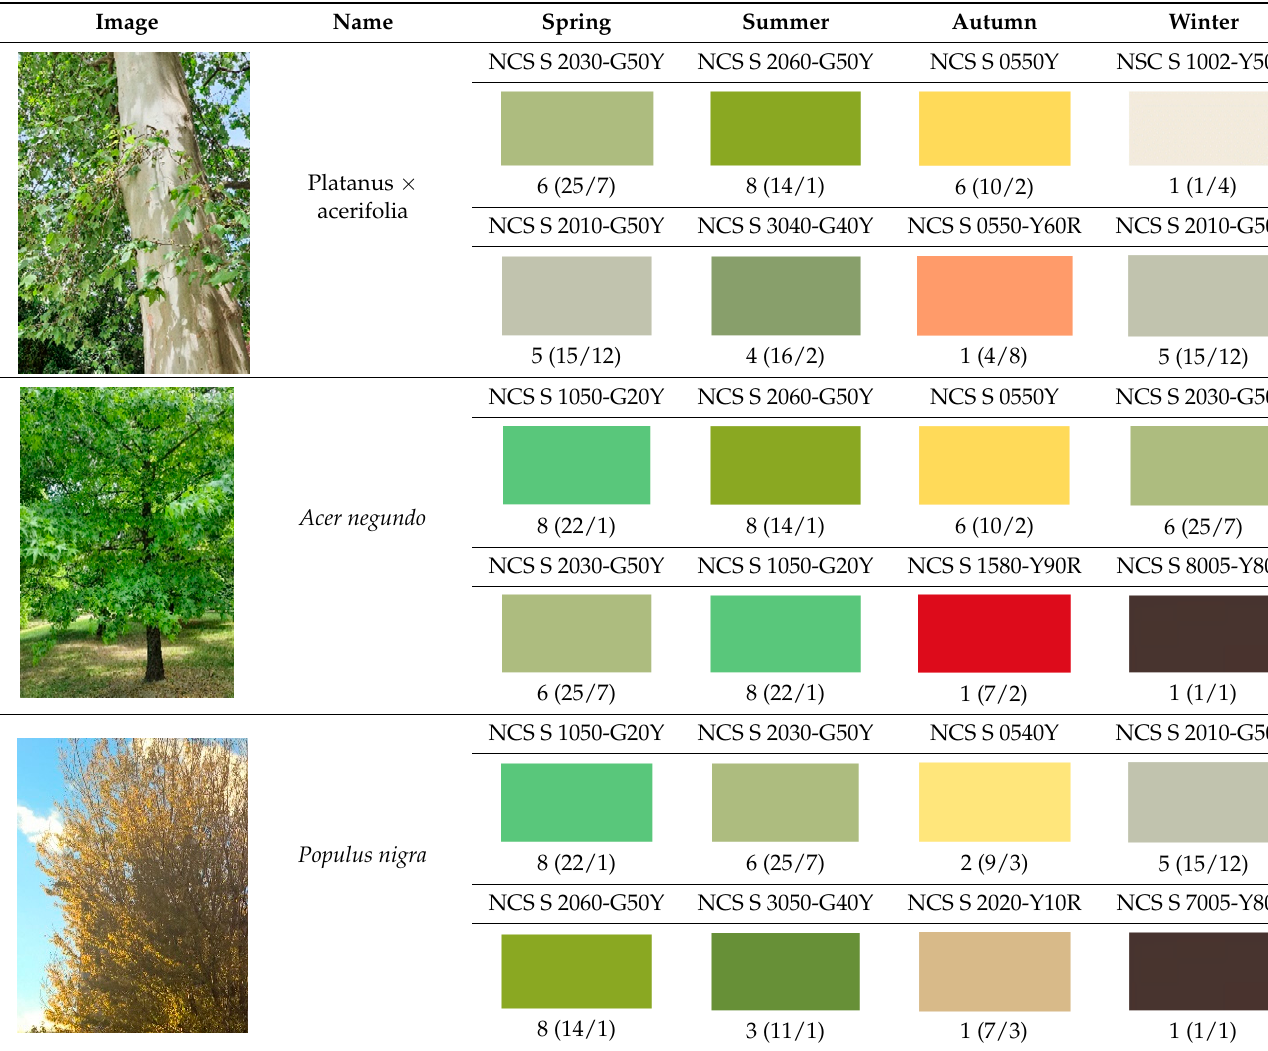
Table A1. Eighty-eight color samples taken from trees identified in the research area. The numbers below the color sample provide the information how many times a given color appears in the table (how many times it appears in all natural